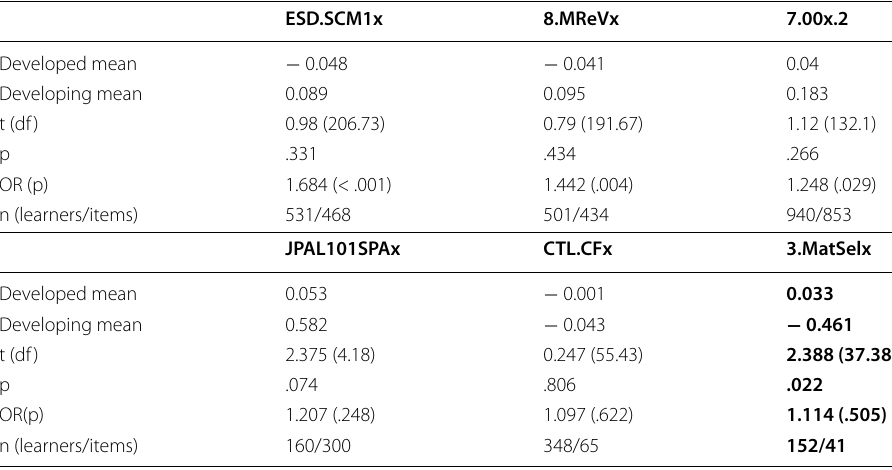
Table 4 RQ4 and RQ5 (bolded half column titled 3.MatSelx) courses completion and assessment bias characteristics ESD.SCM1x 8.MReVx